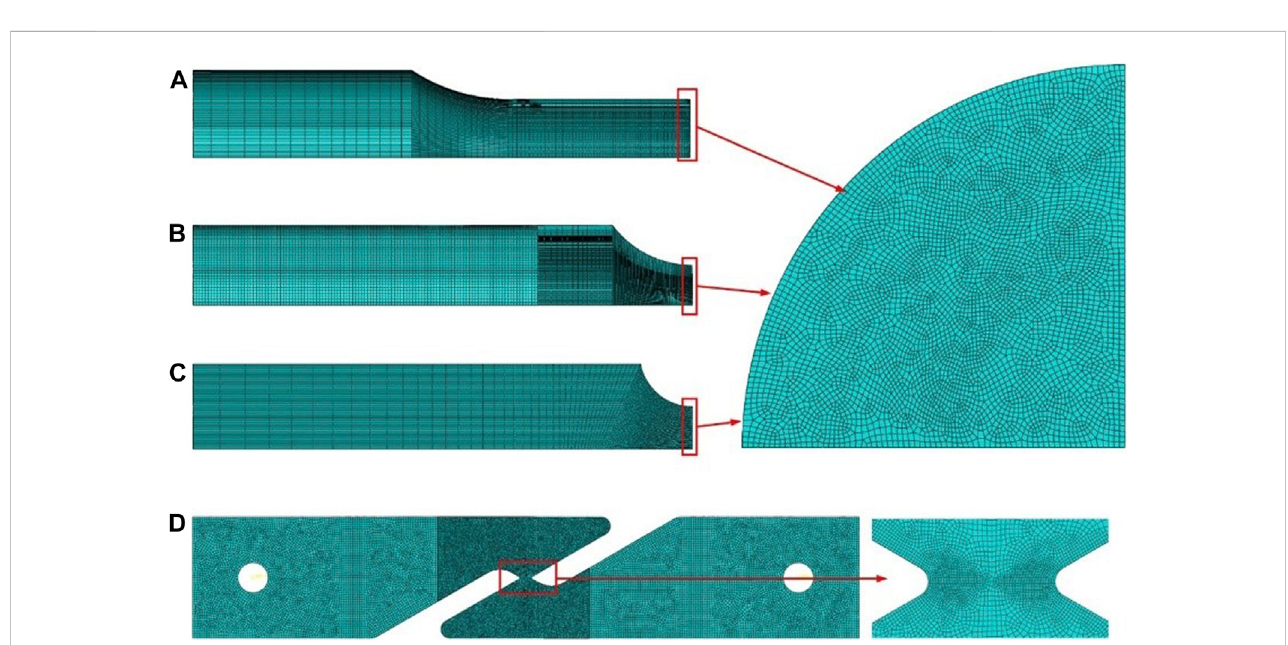
FIGURE 4 Typical FEA models of the selected tension tests: (A) smooth round bar, (B) notched round bar, R = 10 mm, (C) notched round bar, R = 5 mm, (D) shear- induced specimen.